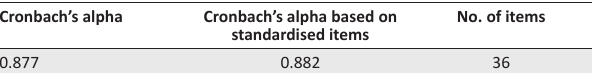
FIGURE 4: Knowledge management practice.